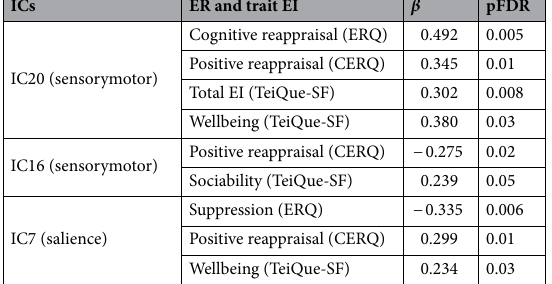
Table 2. Summary of the main neural results. Beta ( β ) and corrected p-value ( p FDR) for the significant relationships between the BOLD temporal variability in the ICs (IC20, IC16, IC7) and both ER strategies and EI